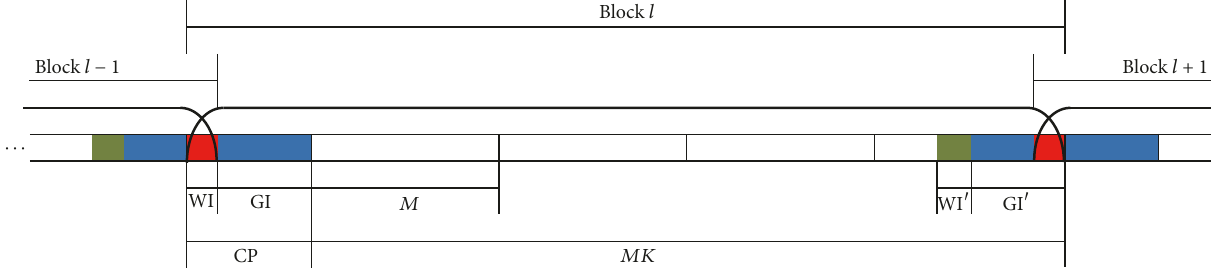
Figure 6: Overlapping of adjacent WCP-COQAM blocks. The regions affected by the window of one block are overlapped with the regions affected by the window of the previous and the next blocks. These regions correspond to the first and the last 𝐿 WI samples of each